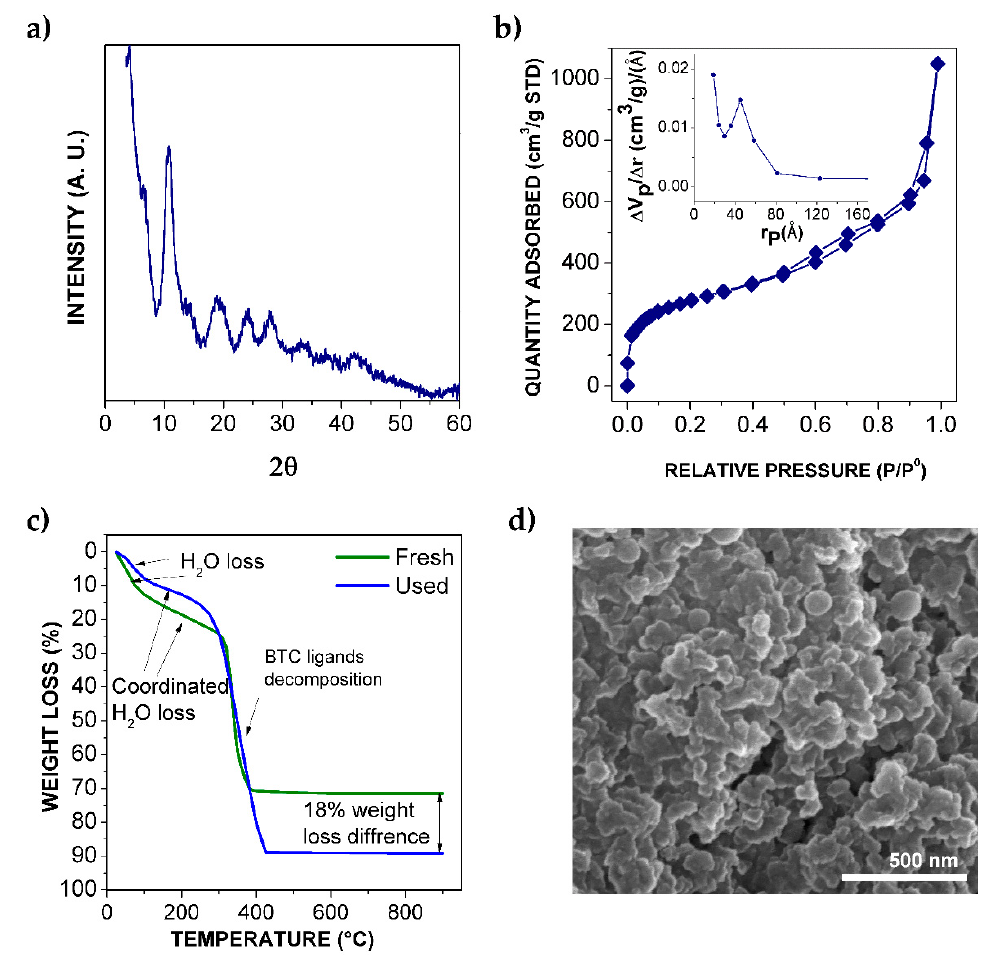
Figure 1. Fe-BTC physical characterization: ( a ) X-ray diffraction (XRD) pattern; ( b ) adsorption isotherm of N 2 , inset: micropore size distribution by BHJ method; ( c ) thermogravimetric analysis (TGA) curves before (fresh) and after reaction (used); ( d ) SEM micrograph of Fe-BTC powder.